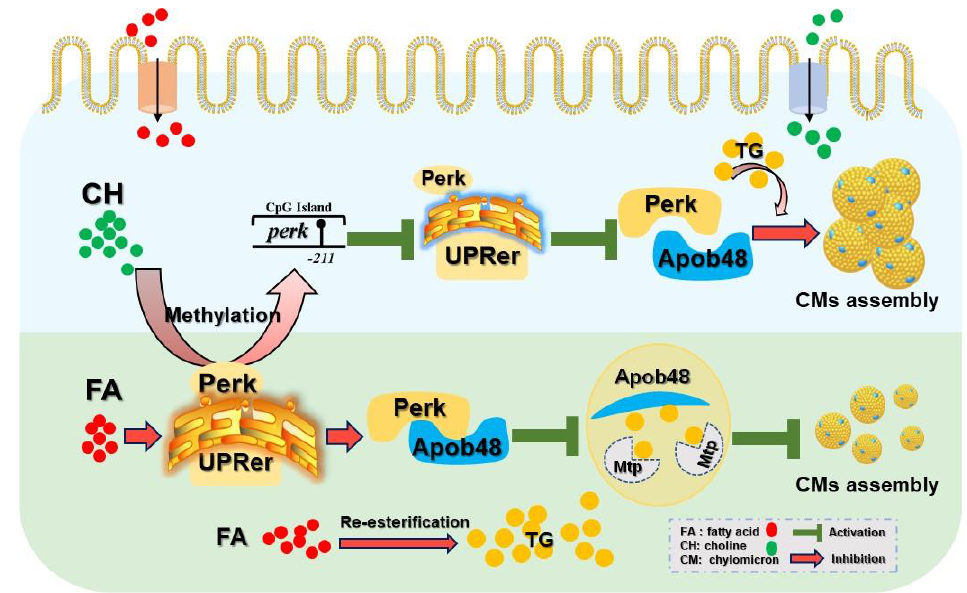
Figure 7. Graphical conclusions for the mechanism of dietary choline mitigates high-fat diet-impaired chylomicrons assembly via UPRer modulated by perk DNA methylation.